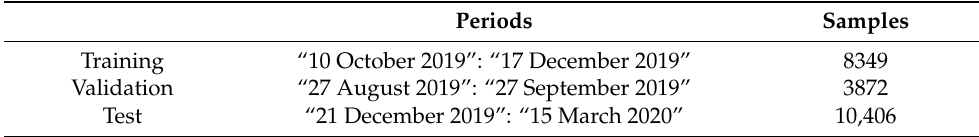
Table 2. Characteristics of the data